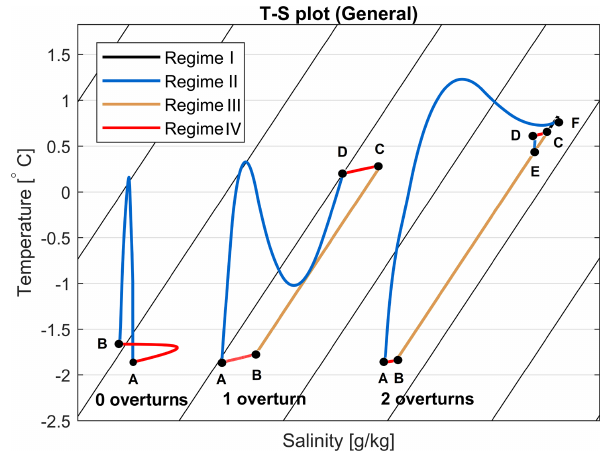
Figure 5. Schematic T 1 – S 1 diagram with arbitrary scale on the salinity axis increasing to the right, showing three general cycles: no overturns (0-overturns; left), one overturn (1-overturn; middle), and two overturns (2-overturns; right) each year. The different model regimes are displayed in black (I), blue (II), orange (III), and red (IV). The letters (A–F) represent regime changes. The cycle starts at A and follows the alphabetical order. The black contours represent isopycnals, and density increases from left to right. No values are used on the salinity axis for clarity (as otherwise the cycles would